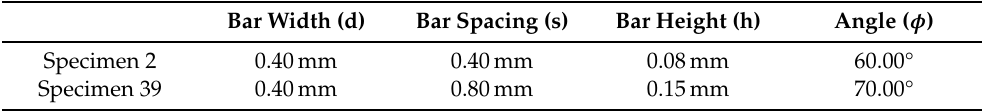
Table 5. Nominal geometry parameters of the